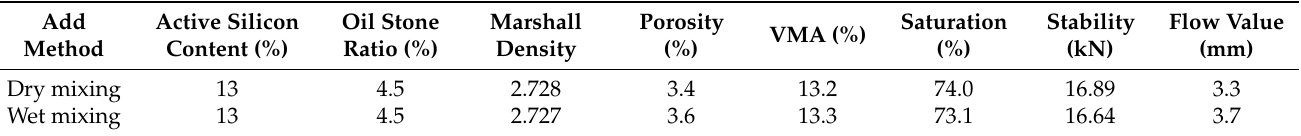
Table 3. Marshall test indexes of dry mixed and wet mixed